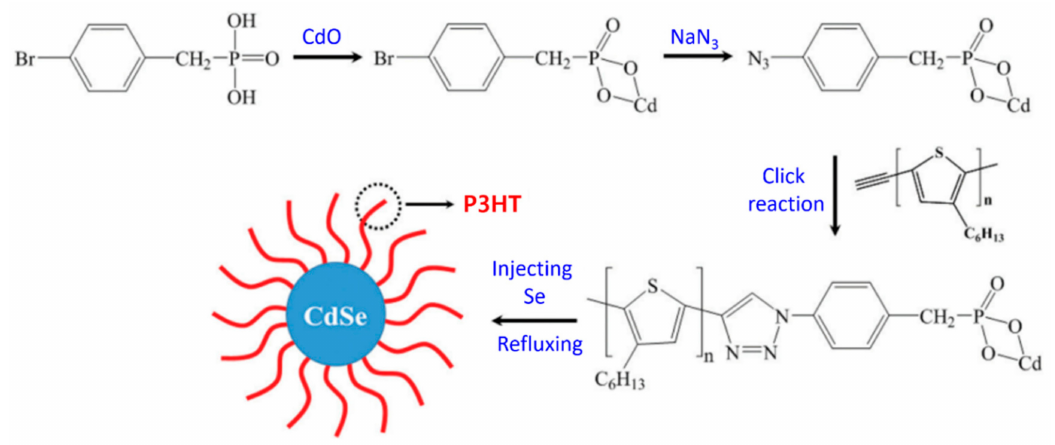
Figure 9. Formation of P3HT-CdSe QD nanocomposites via in situ growth. Reprinted with permission from [23]. Copyright 2016, Royal Society of